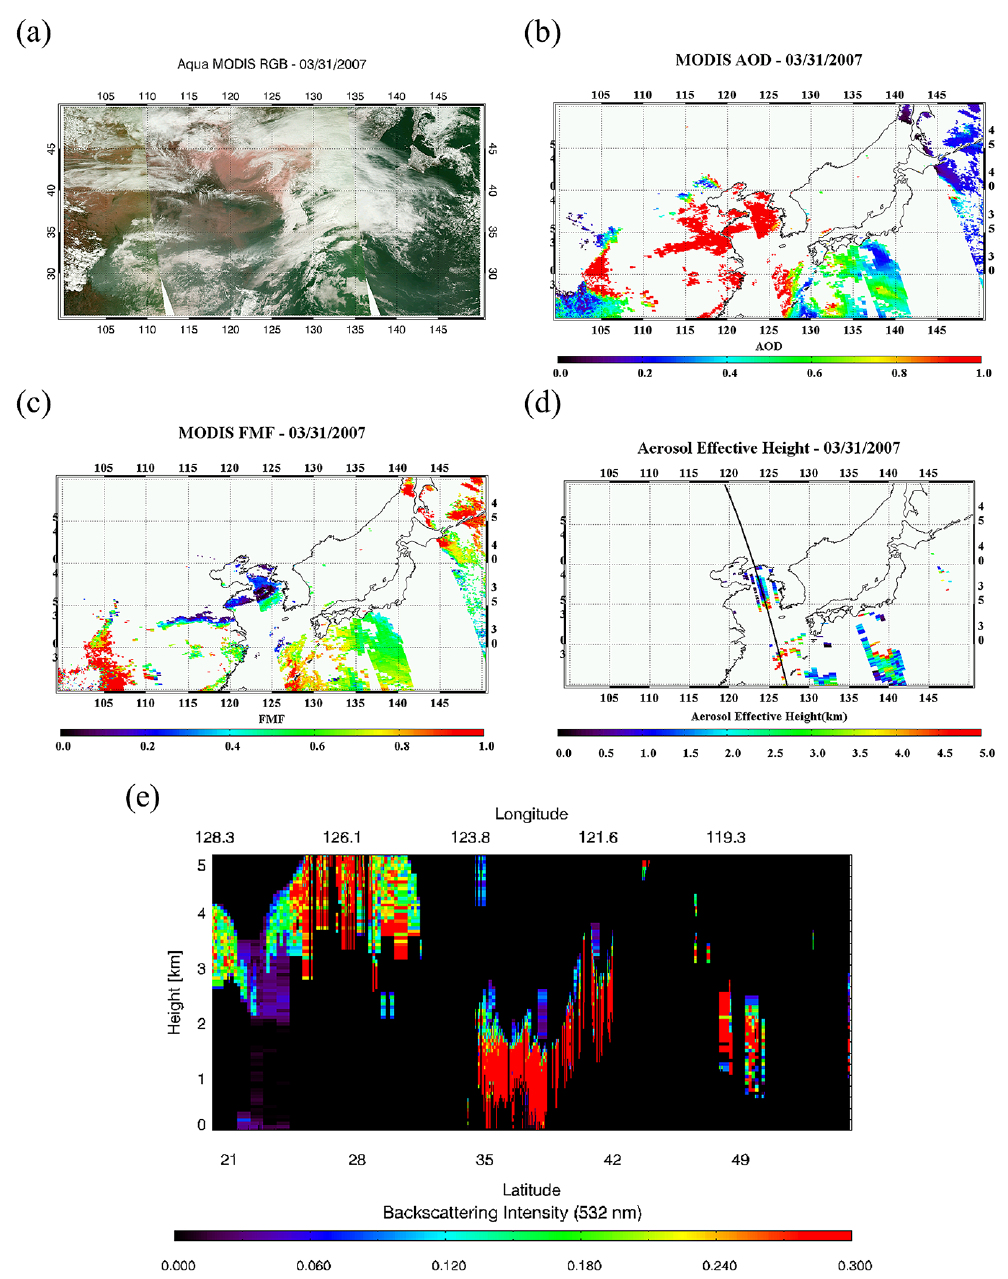
Figure 13. (a) MODIS RGB, (b) AOD, and (c) FMF; and (d) AEH distribution from OMI over East Asia; (e) backscattering intensity at 532nm from CALIOP observations over the Yellow Sea on 31 March